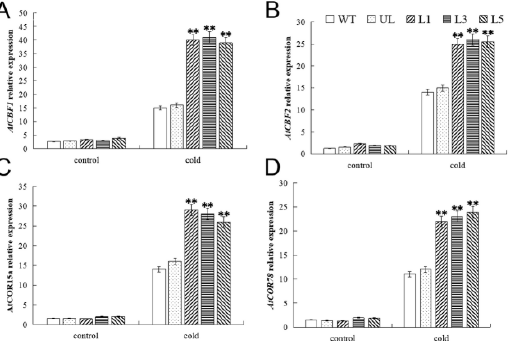
Figure 10. Expression of chilling-related genes in transgenic A. thaliana lines overexpressing FvMYB82 under low-temperature treatment. Relative expression levels of ( A ) ATCBF1 , ( B ) AtCBF2 , ( C ) AtCOR15a , and ( D ) AtCOR78 in the WT, UL, and transgenic lines (L1, L3, and L5). Data are the average of three repetitions. Asterisks indicate extremely significant differences between the transgenic line and the WT (** p ≤ 0.01).